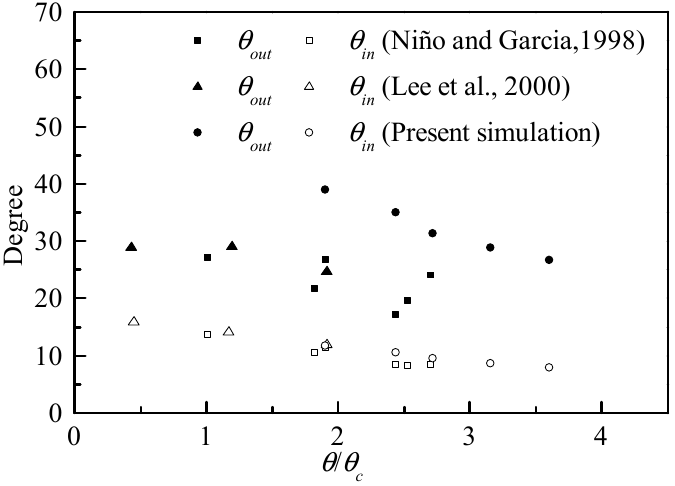
θ and takeoff angles in